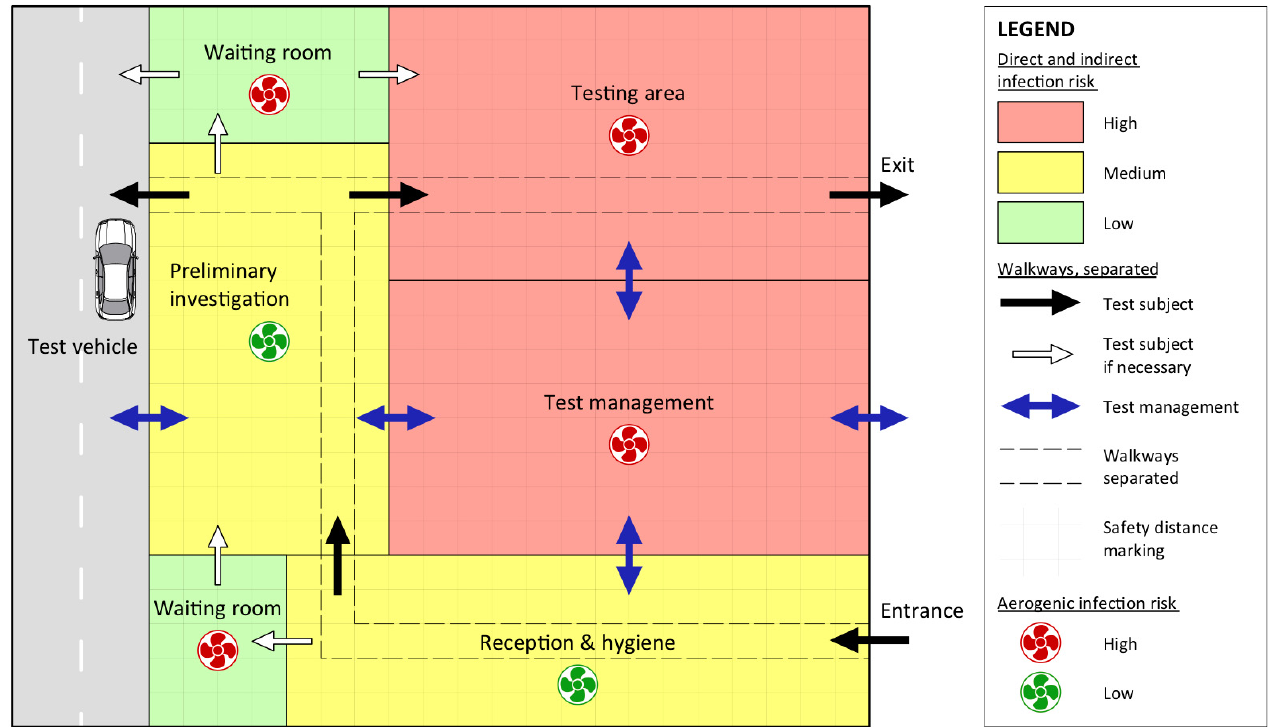
Figure 4. Indoor floor plan example for conducting a study in a room or vehicle. The walking routes of the subjects are shown with black and white arrows, while the walking routes of the test administration are marked with blue arrows. Since the investigators have to enter each room, their entry and exit is not restricted. The subjects, however, can only move from entrance to exit in the direction shown. In addition, Figure 4 shows the relative risk of infection by the color of the room. The waiting rooms have a low risk (green) of direct or indirect contact or droplet infection, since only one volunteer can be in the waiting room at a given time. Rooms colored yellow have a medium risk of infection, as two people are present in these rooms at the same time. Red rooms, such as the experimental room and the management’s common area, have a high risk of infection, since at least two people are present in these rooms for a longer time. In the rooms marked in yellow and red, it is therefore particularly important to pay attention to the basic infection protection measures (e.g., safe distance, respiratory mask, hygiene). Additionally, a green or red rotor symbol represents the risk of aerogenic infection. A green rotor symbol, as seen in the reception or hygiene rooms, denotes a low risk of infection due to aerosol exposure. These rooms as well as the pre-examination room, are only used for short time periods. In all other rooms, a high risk of aerogenic infections is symbolized by the red rotor, as several people may be present in these rooms for longer periods of time. While waiting rooms are occupied by only one person at a time, they